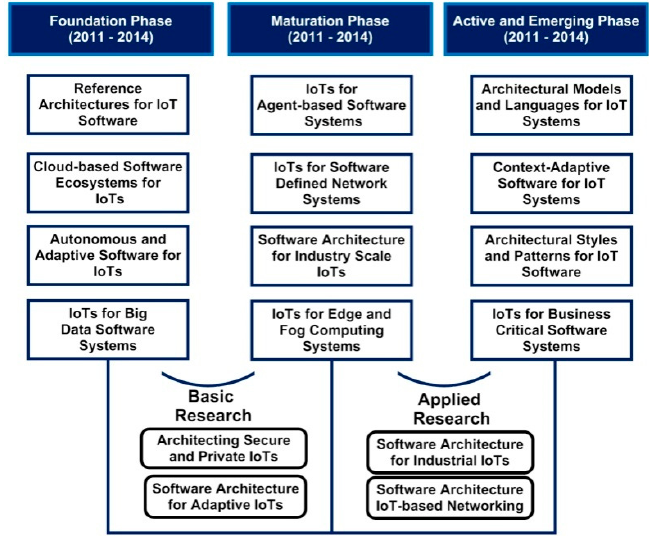
Figure 9. Overview of the Three Phases of Research on Architecting IoT Software.